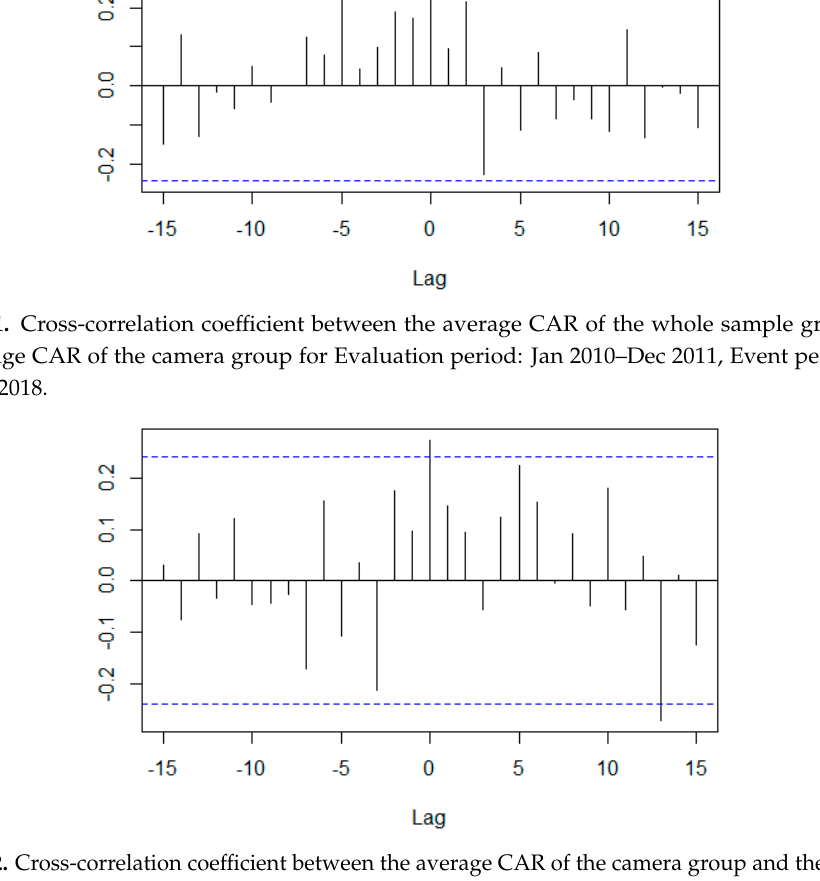
Figure 12. Cross-correlation coefficient between the average CAR of the camera group and the average CAR of the display group for Evaluation period: Jan 2010–Dec 2011, Event period: Jan 2013–Jul 2018.